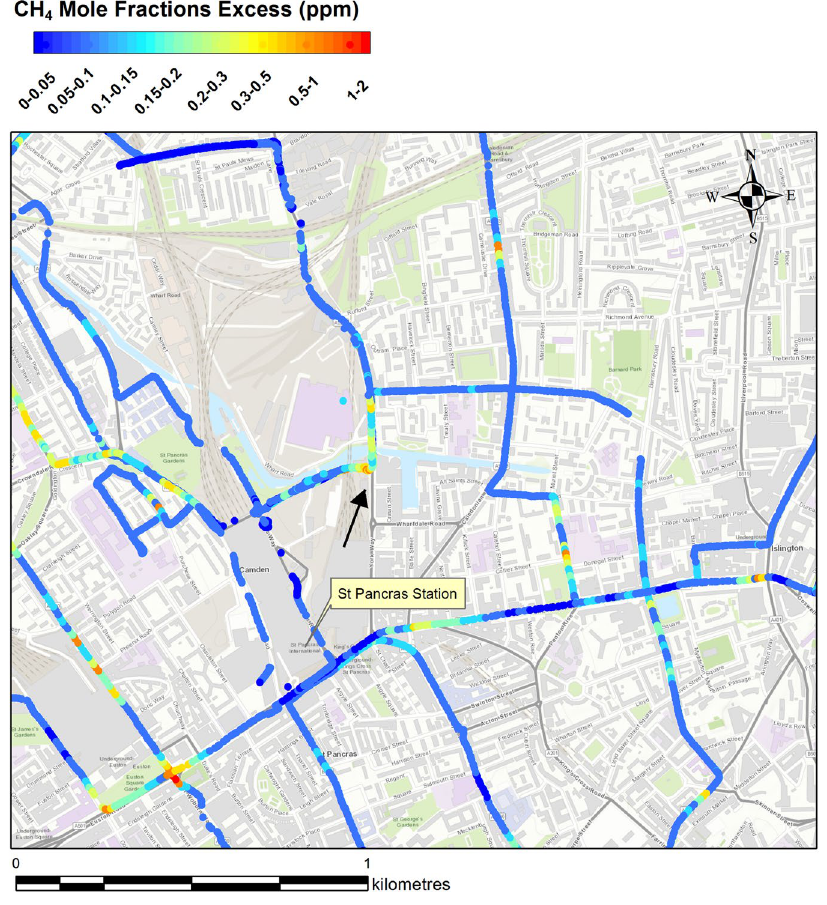
Figure 7. CH 4 mole fraction excess over the background measured overnight on 14 th and 27 th April with the Picarro mobile system in the Borough of Camden. The black arrow indicates location of the sample collected. The map was generated using ArcMap 10.2. Base map source: Esri, HERE, DeLorme, Itermap, increment Corp., GEBCO, USGS, FAO, NPS, NRCAN, GeoBase, IGN, Kadaster NL, Ordinance Survey, Esri Japan, METI, Esri China (Hong Kong), swisstopo, MapmyIndia, OpenstreetMap contributors, and the GIS User